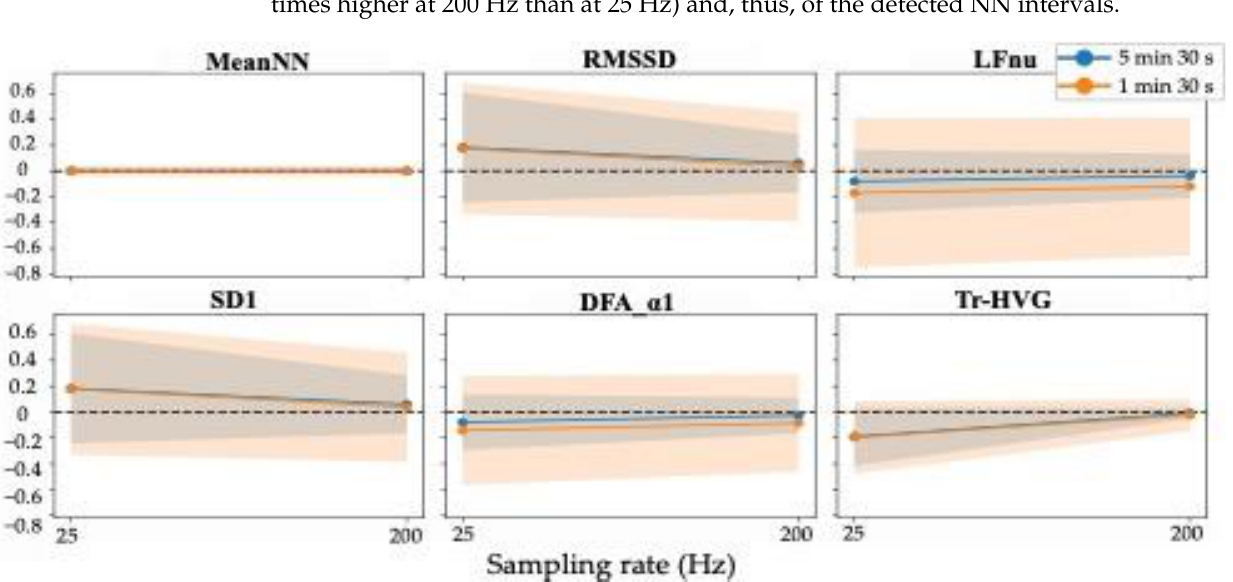
have strong correlation coefficients (>0.7), negligible C liff’s delta (δ < 0.11), and statistical equiva- lence ( p -value < 0.05).